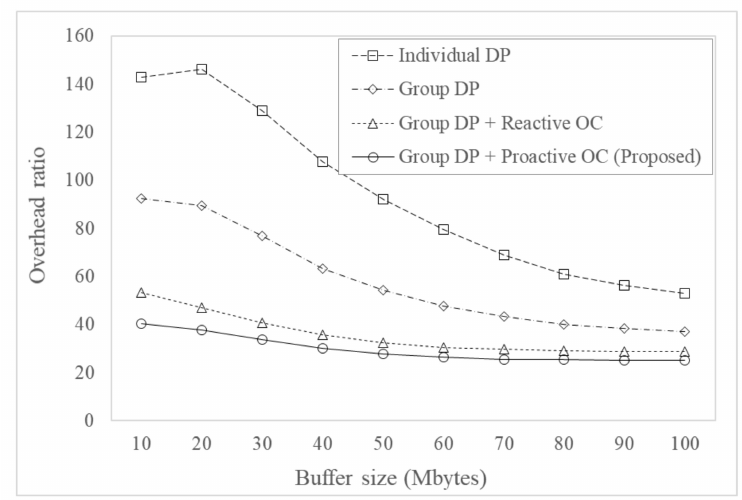
Figure 6. Overhead ratio for varying buffer